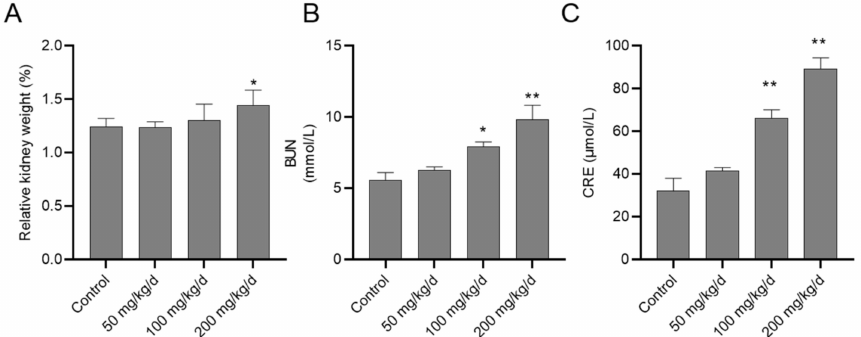
Figure 1. The changes of relative kidney weight ( A ) and the levels of serum blood urea nitrogen (BUN) ( B ) and serum creatinine (CRE) ( C ) in mice exposed to copper sulfate (CuSO 4 ). The mice were orally administrated with copper sulfate (CuSO 4 ) at the dose of 50, 100 and 200 mg / kg / day for 28 days, the relative kidney weight, BUN and CRE were examined. Data are presented as mean ± SD ( n = 10). * p < 0.05, or ** p < 0.01, compared to the control